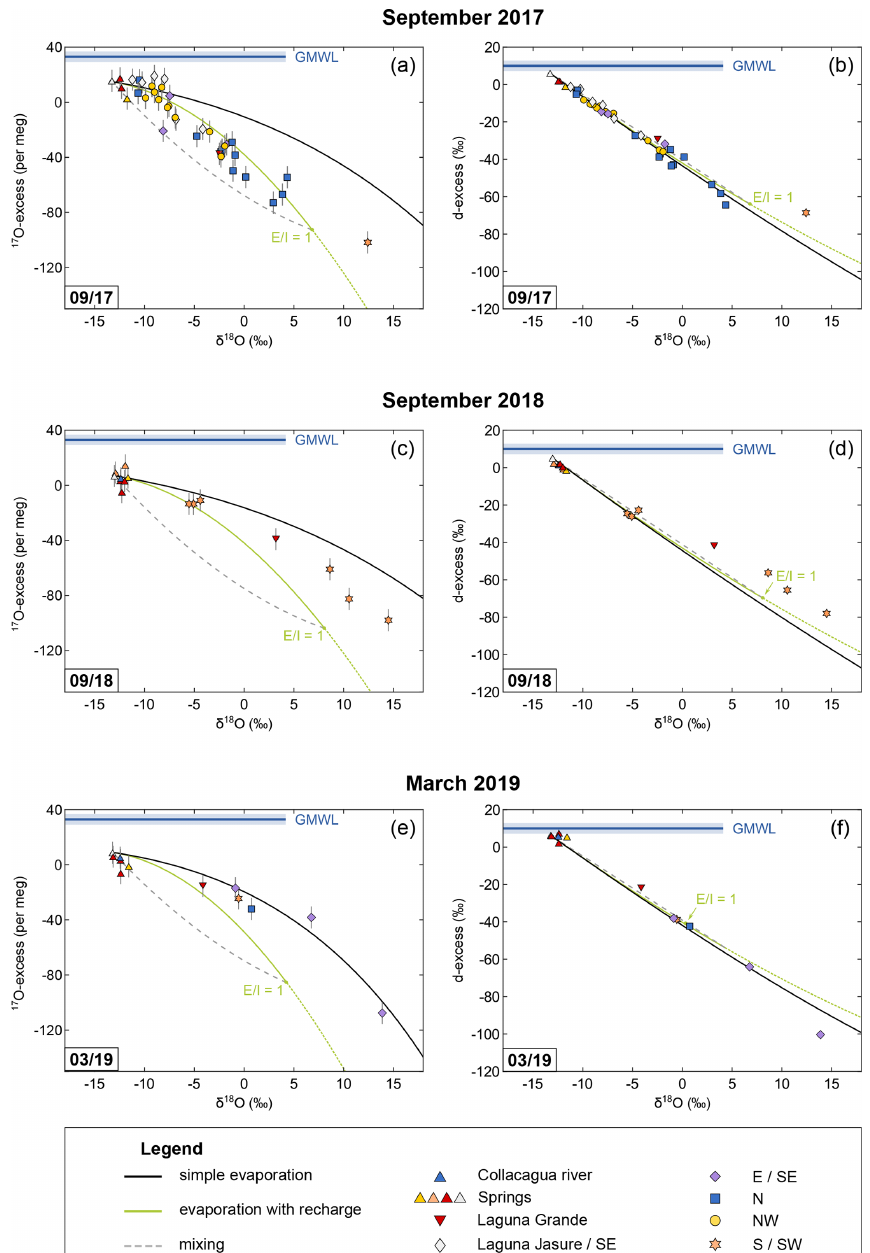
Figure 4. Oxygen and hydrogen isotope data of the Collacagua river, springs, lakes, and ponds sampled in the Salar del Huasco basin during field campaigns in September 2017 (a, b) , September 2018 (c, d) , and March 2019 (e, f) . Colour coding refers to different hydrological subsystems (see legend and cf. Fig. 2). Note that the symbol size can be larger than the error bars. Trajectories for simple evaporation (black) and evaporation with recharge (green) were modelled using input parameters as summarized in Table 3. To calculate temperature and relative humidity, daytime (06:00–18:00CLT) conditions of the 10d (March 2019) or 20d (September 2017, September 2018) prior to sampling were considered (cf. Sect. 6.3). Additionally, admixture of fresh groundwater (dashed grey line) as it might occur during flooding or snowmelt is exemplified for the case of a terminal lake (E / I = 1). The global meteoric water line (GMWL) serves as reference. Note that the apparent lack of samples on a recharge evaporation trajectory in September 2018 and March 2019 is simply the result of a sampling focus on sources and on ponds cut off from recharge during these